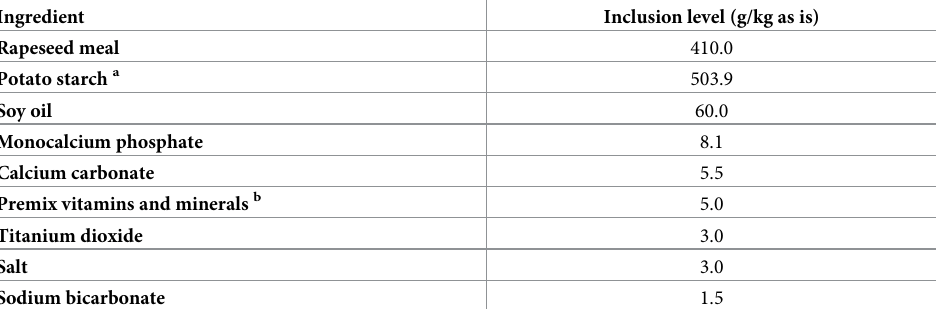
Table 1. Ingredient composition of the experimental diets.